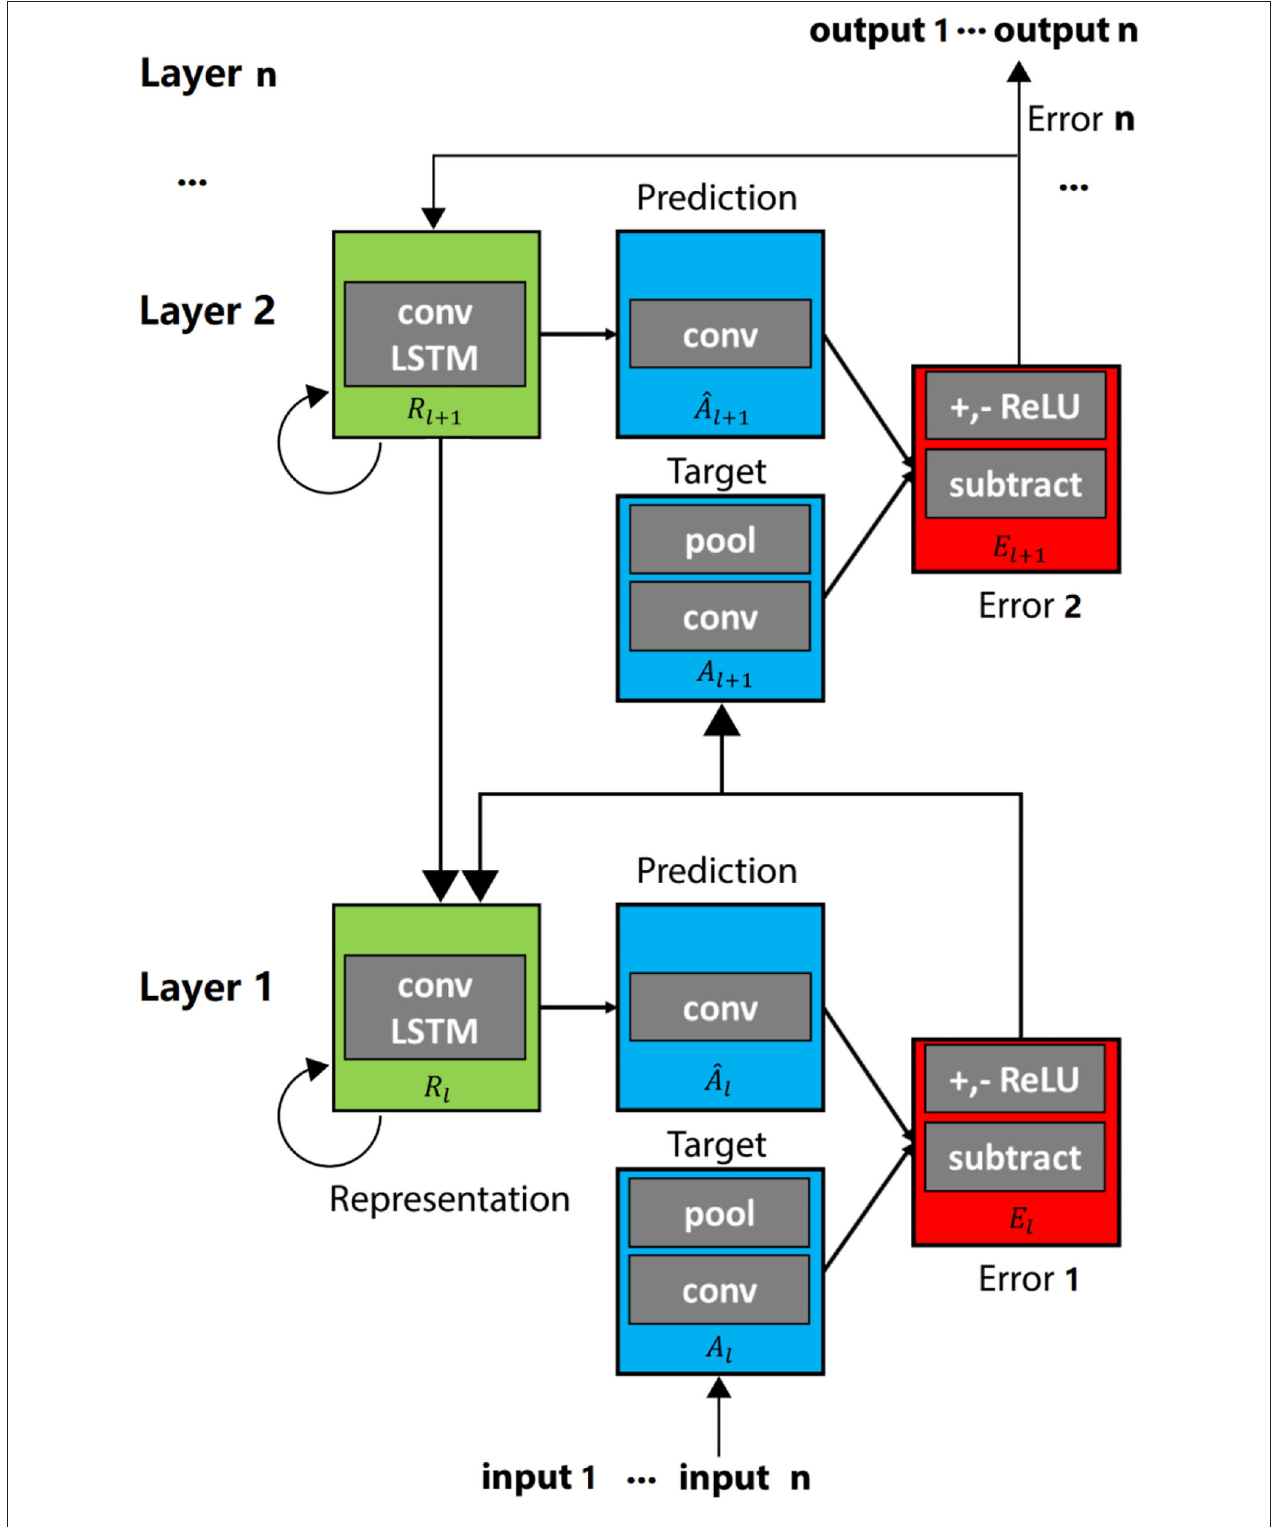
FIGURE 2 | The sketch block diagram of